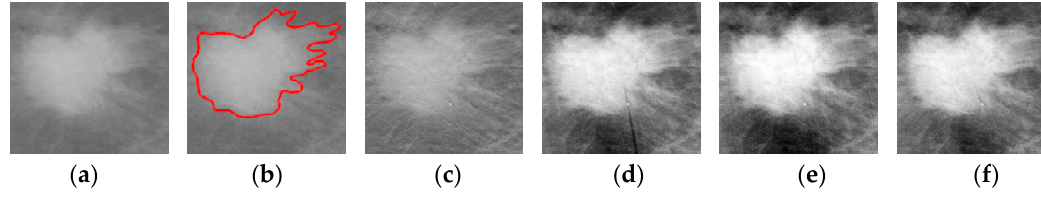
Figure 2. ( a ) Original region of interest (ROI); ( b ) AD area marked by expert; ( c ) top–bottom hat transformation result (length 50, angle 100); ( d ) top–bottom hat transformation result (length 100, angle 100); ( e ) top–bottom hat transformation result (length 200, angle 100); and ( f ) top–bottom hat transformation result (length 100, angle 130).